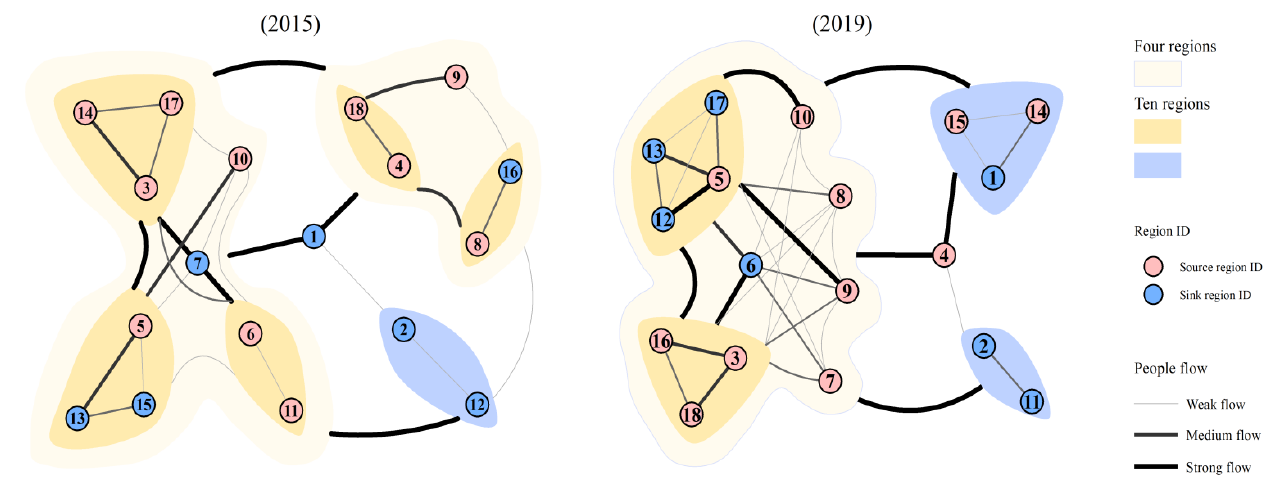
Figure 7. The “source -flow- sink” organization model of population flow in China.